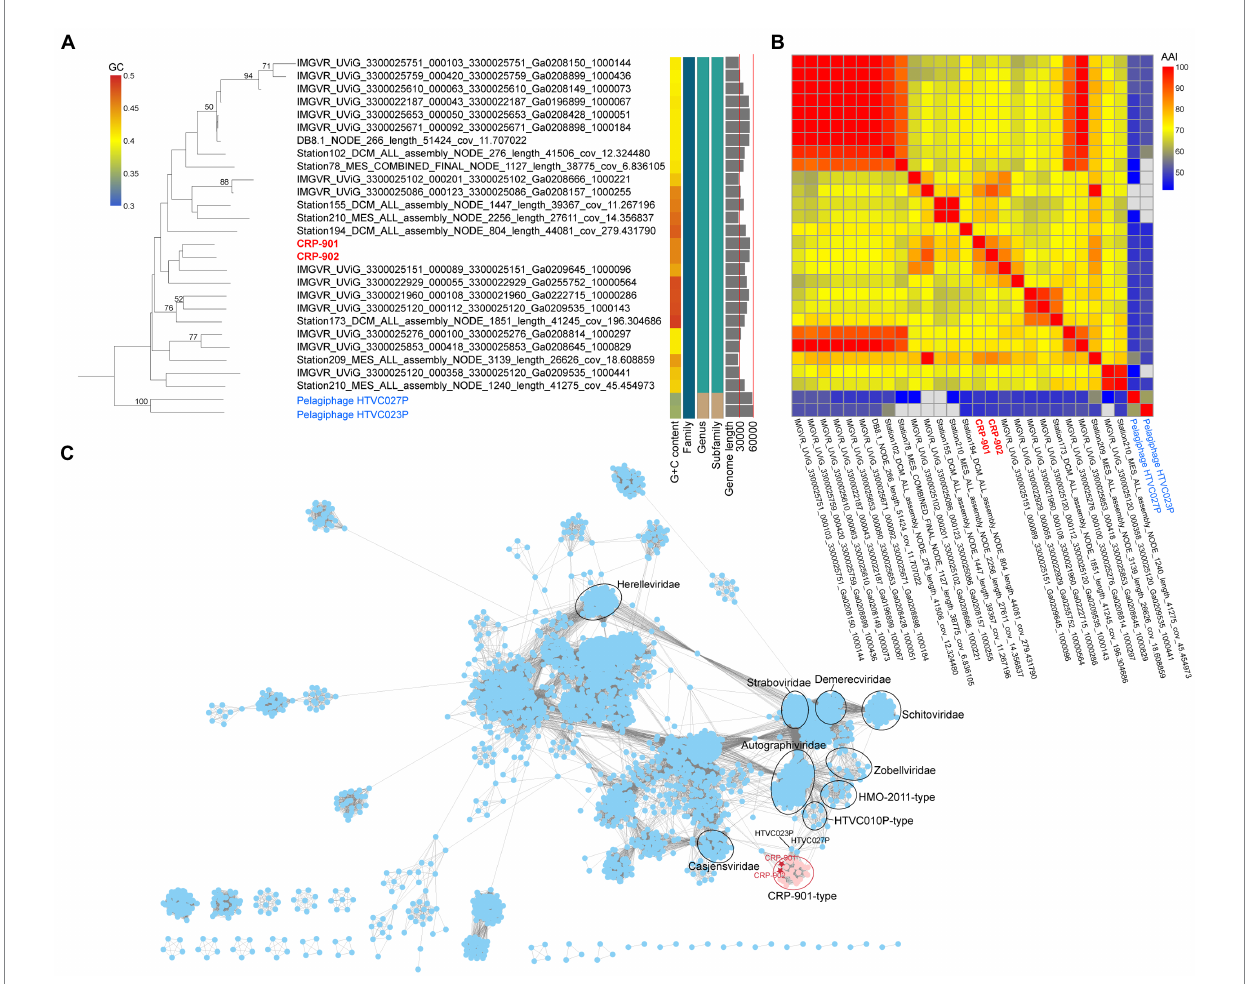
FIGURE 3 Phylogenetic relationship and viral network of protein content similarity analysis. (A) Whole-genome phylogenetic tree based on amino acid sequences constructed by VICTOR with the formula d 0 (Meier-Kolthoff and Goker, 2017). CRP-901 and CRP-902 are shown in red, and the pelagiphage HTVC023P and HTVC027P are in blue. The predicted OPTSIL taxon at family, subfamily, and genus are shown as well as the G + C content and sequence length. The bootstrap value of ≥ 50 is shown on nodes. (B) Heatmap showing the average amino acid identity (AAI) value between phage genomes. (C) Gene-content-based viral network of CRP-901-type phages and other known viruses from NCBI-RefSeq (v212) constructed by vConTact 2.0. The nodes represent the viruses, and the edges represent the similarity score between two phages, with a cutoff of ≥ 1. Related phages are circled. CRP-901 and CRP-902 are indicated with red asterisks, and the viral cluster represented by CRP-901 and CRP-902 is shown as a red